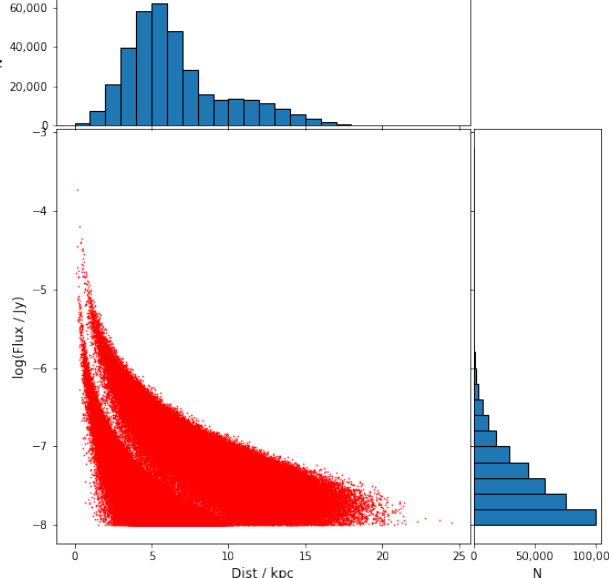
Figure 6. The distribution of distance and estimated fluxes of detectable Be stars. The upper panel is for the distance, while the right is for the flux. The middle panel shows how the flux varies with distance. The apparent gap is caused by our flux prediction, which is bi-modal, as described in Section 2.4.